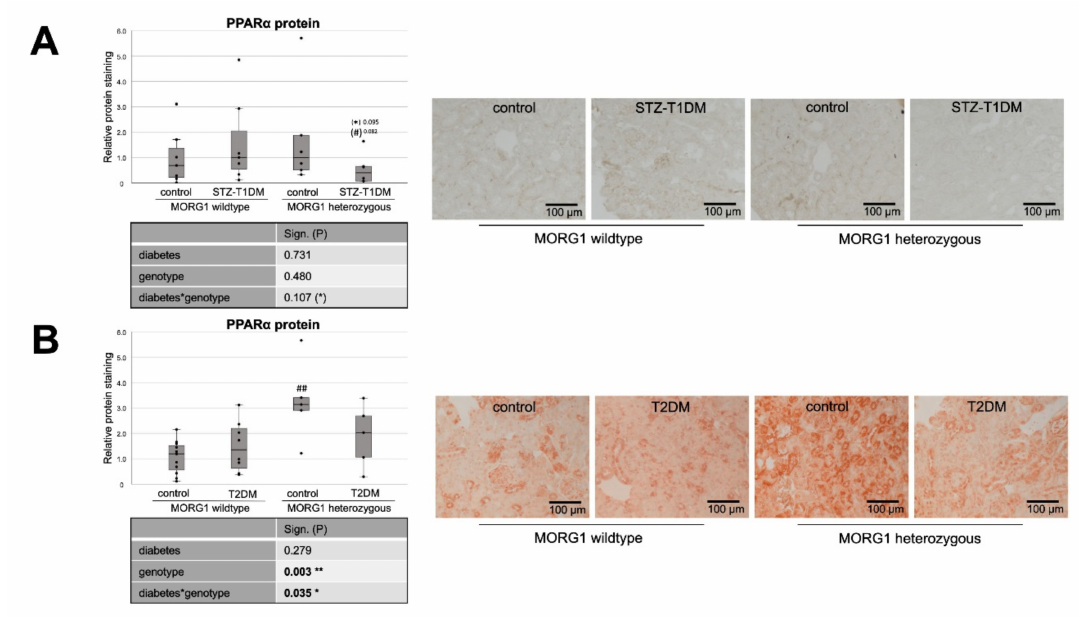
Figure 4. Role of MORG1 in renal expression of transcriptional factor of β -oxidation. ( A , B ) Immuno- histochemistry of PPAR α (peroxisome proliferator activated receptor alpha) protein in STZ-T1DM and T2DM with 10 non-overlapping images per animal and semi-quantitative analysis of the staining. Representative images are shown next to the graphs (magnification × 200). The significances shown in the tables were assessed by two-way ANOVA with diabetes (control or STZ-T1DM/T2DM) and geno- type (MORG1 wild-type or MORG1 heterozygous) as the two factors. Diabetes, genotype: main effect of diabetes/genotype, respectively. Diabetes*genotype: interaction. Bold: statistically significant. U test; * p ≤ 0.05 in between same genotype; ## p ≤ 0.01 in between different genotypes; (*)